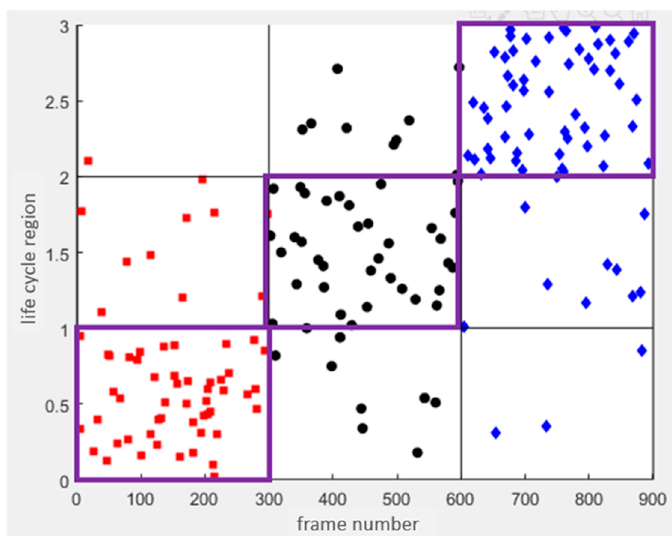
Figure 6. Testing Result of Life Cycle Model.